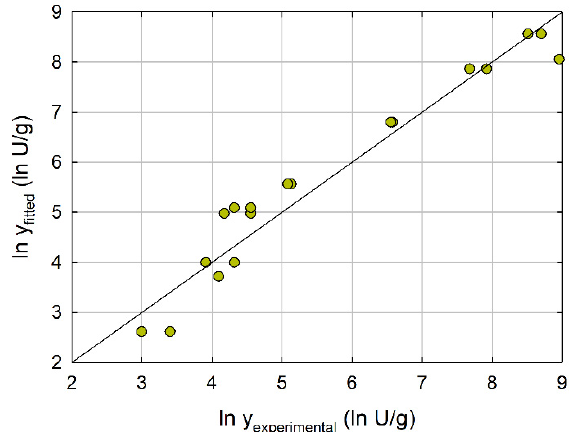
Figure 2. Linear regression of the model obtained in optimization of LipMatCCR11-CLEA production.